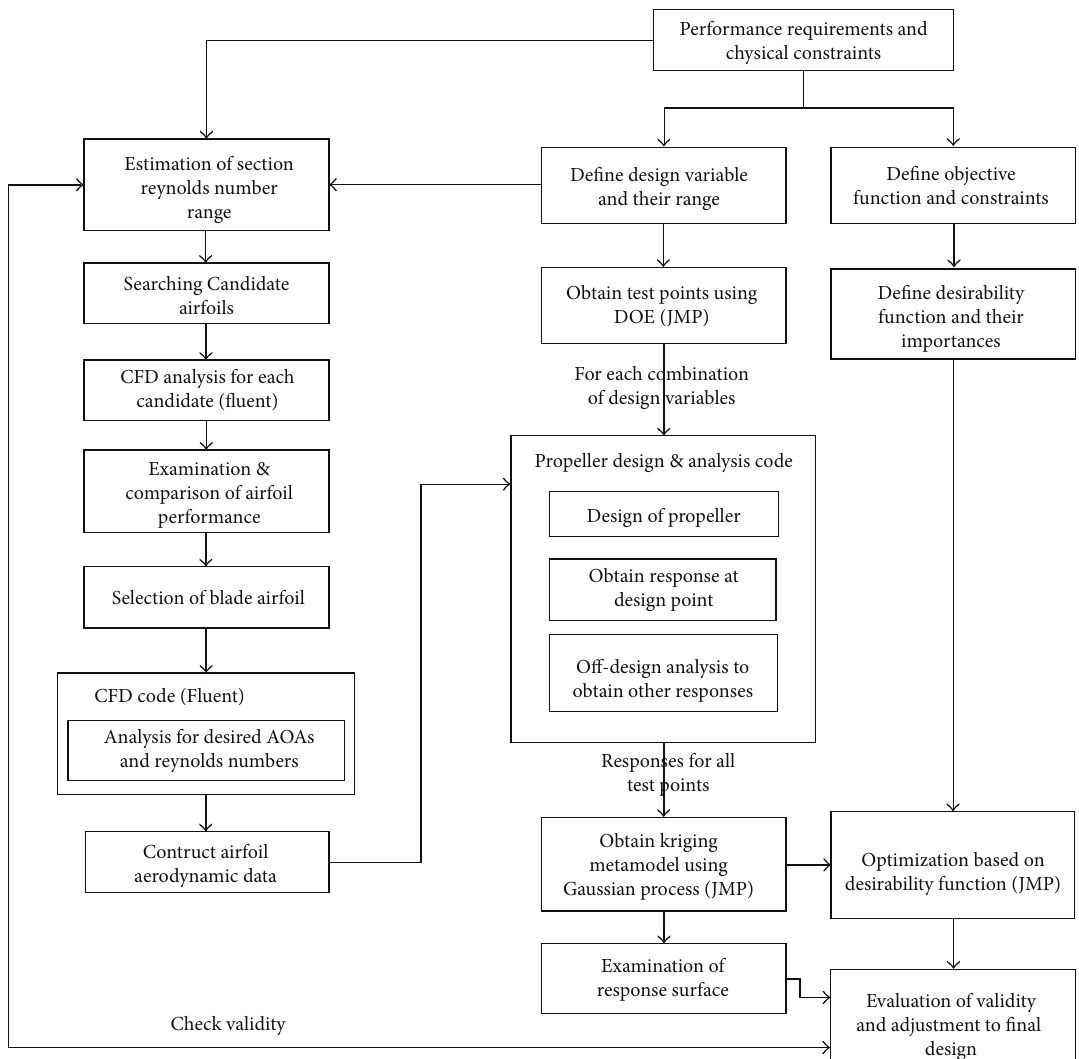
Figure 13: Flow chart of design of propeller for EAV-3.